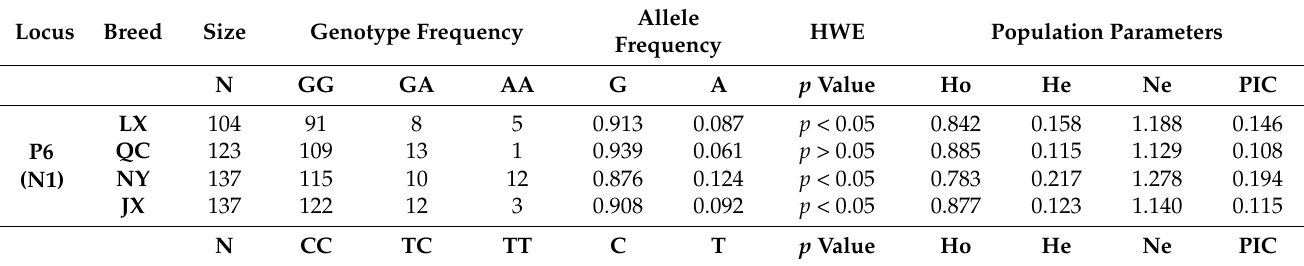
Table 4. Genotypes, alleles, He, Ne, and PIC for variations of the cattle PSAP 3’